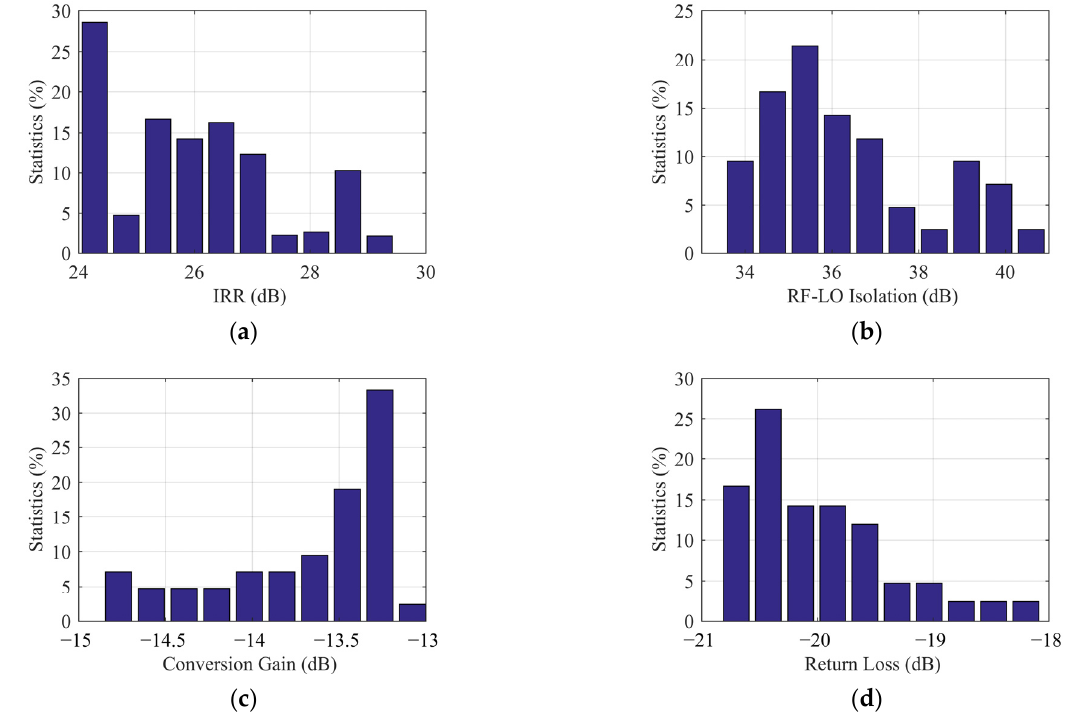
Figure 11. Statistical results of Monte Carlo simulation ( a ) IRR. ( b ) RF-LO isolation. ( c ) Conversion Gain. ( d ) RF Return Loss.